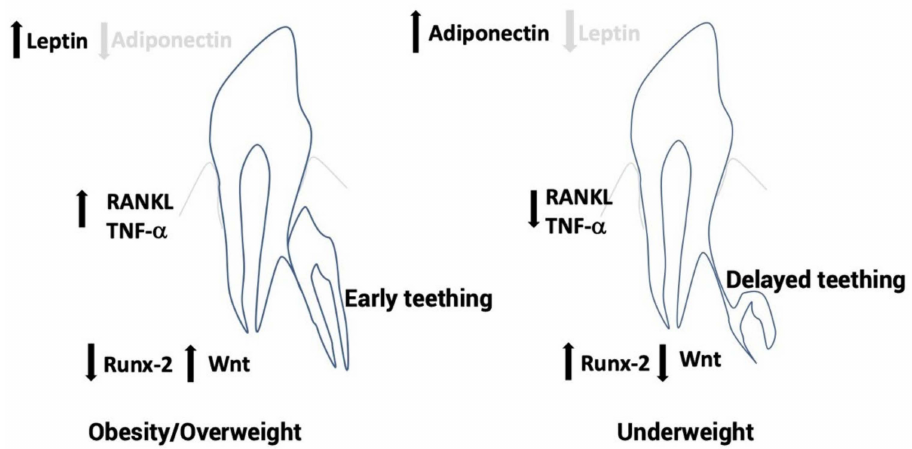
Figure 1. Under obesity/overweight conditions, early permanent teeth eruption would be explained by increased leptin levels that decrease runt-related transcription factor 2 (Runx 2) expression increas- ing Wnt gene expression, receptor activator of NF kappa-b (RANK-L), and TNF- α . In underweight conditions, delayed permanent tooth eruption would be explained by increased adiponectin levels or decreased adiponectin. This promotes Runx 2 expression resulting in Wnt reduced expression and decreased pro-inflammatory RANK-L and TNF- α